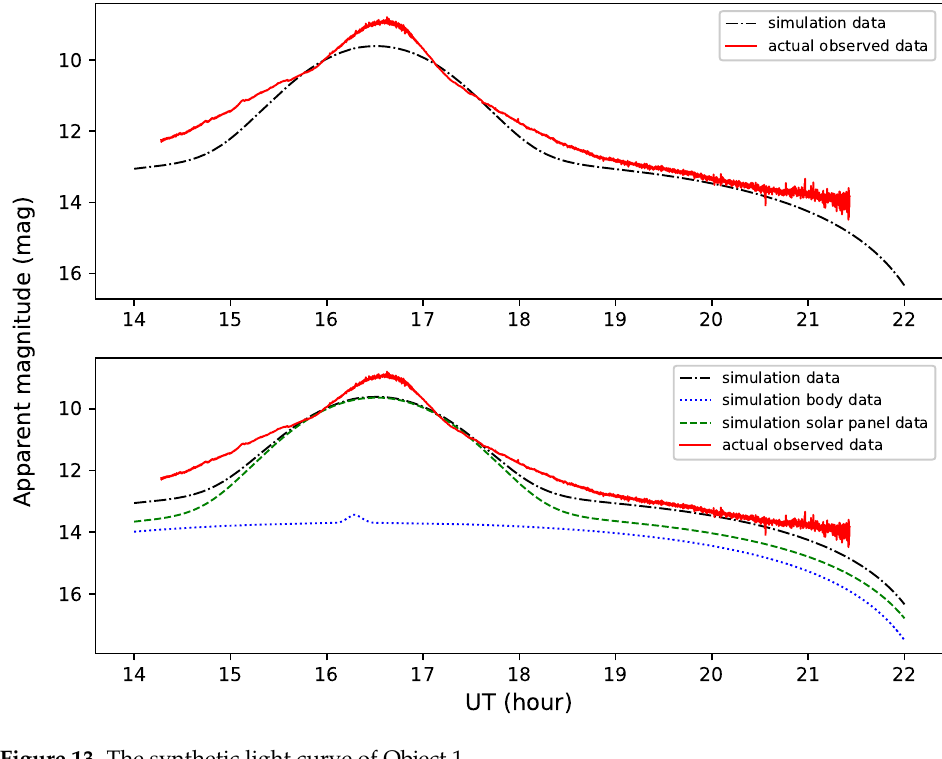
Figure 13. The synthetic light curve of Object 1.